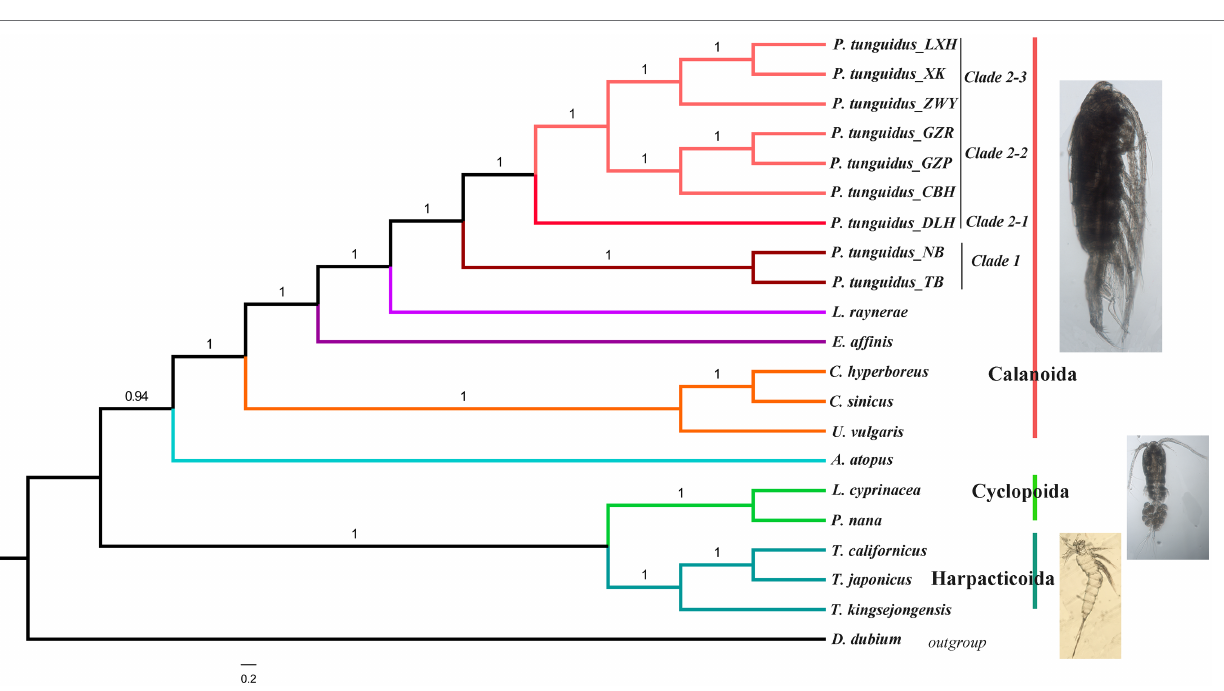
FIGURE 7 | Phylogenetic relationship among Copepods reconstructed with 13 mitochondrial PCGs. Numbers at nodes represent the posterior probability in the BEAST